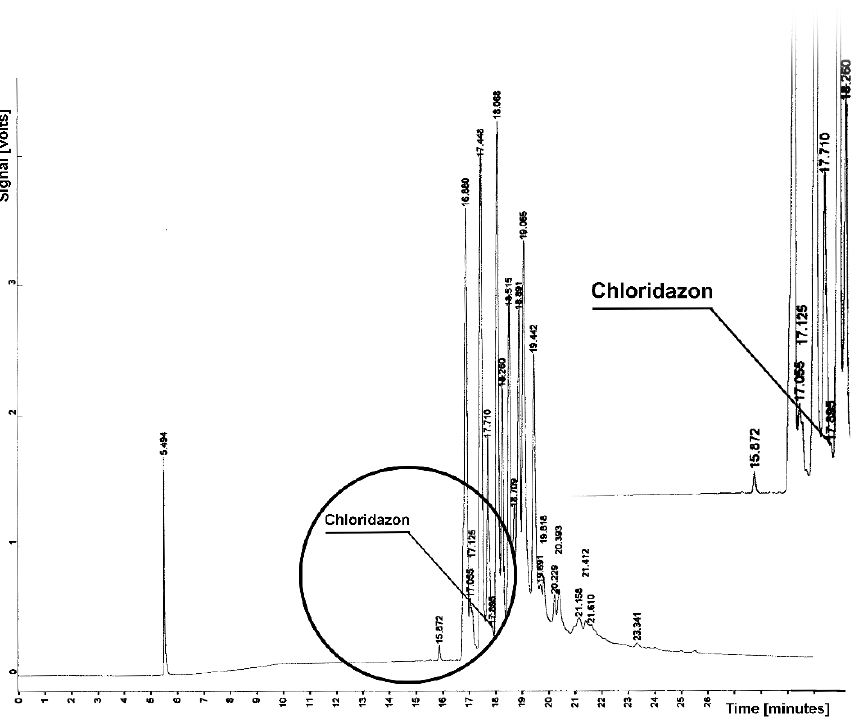
Figure 4. Chromatogram from determination of chloridazon residue in sample from soil extraction; tR = 17.895—chloridazon.